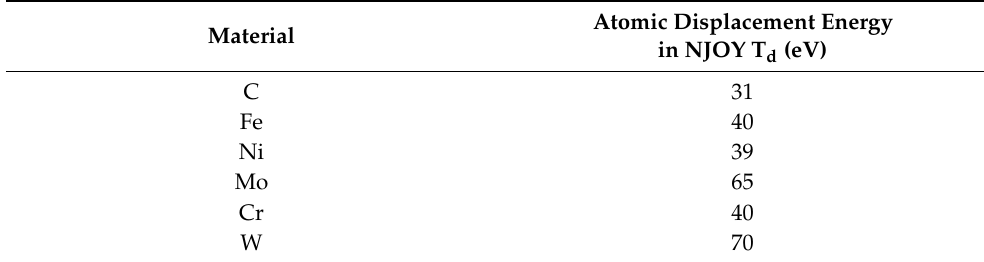
Table 3. Atomic displacement threshold energy